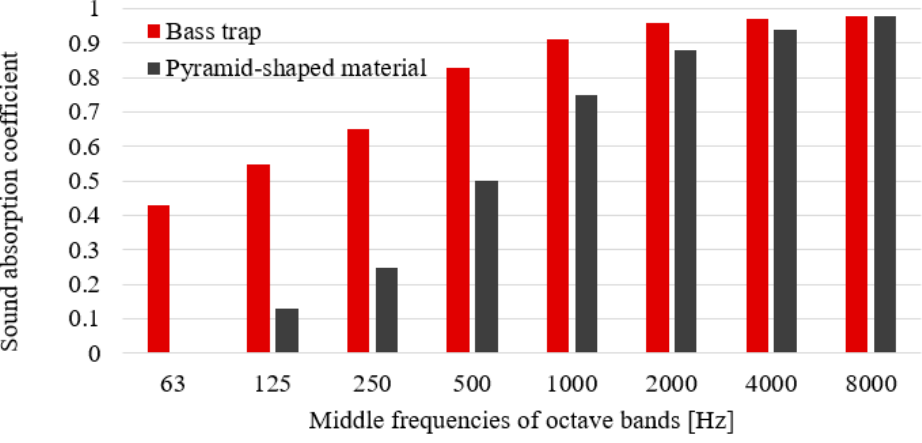
Figure 8. Sound absorption curves for both materials used.